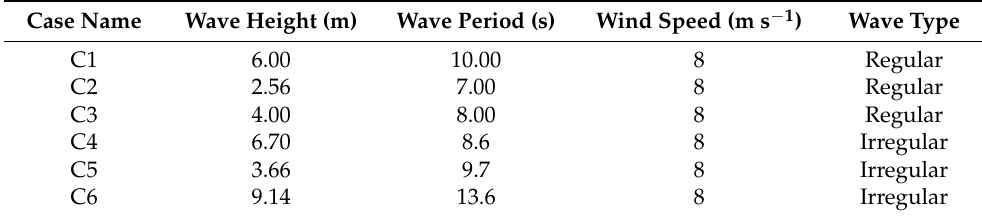
Table 2. Environmental condition